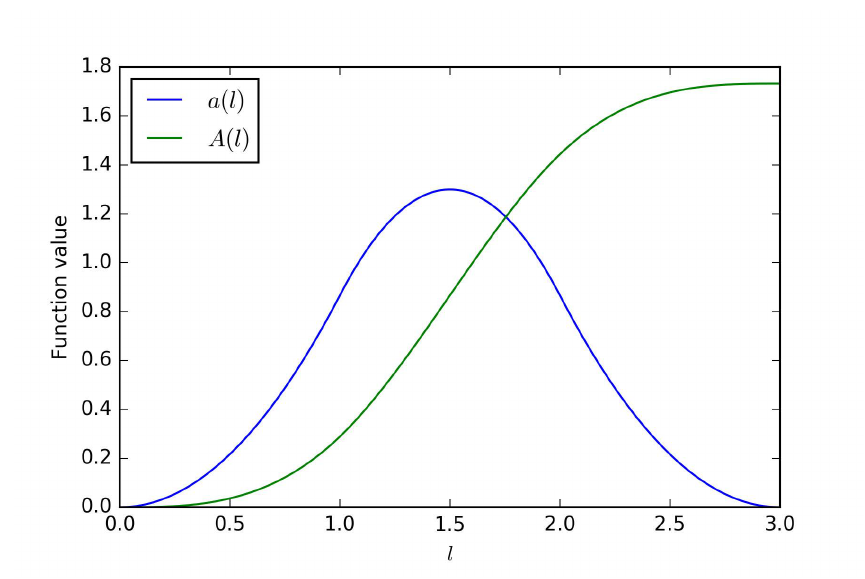
Figure 2. Area of cross section of RGB color cube and equiintensity plane, a ( l ) , and its integral, A ( l )